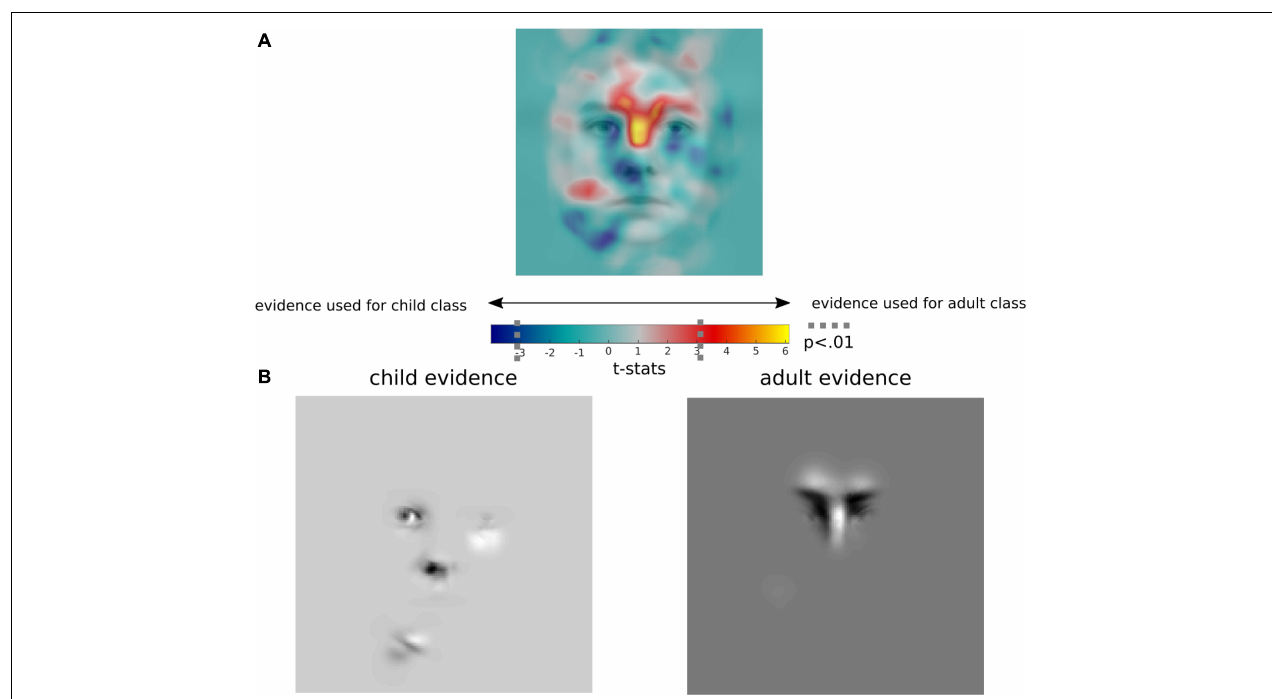
FIGURE 2 | Facial features for child and adult categorisation. Regression coefficients for 2D feature positions (for accurate classification of child and adult images) were spatially smoothed, and compared between child and adult faces with unpaired t -tests. On the first panel (A) , hot colours (positive t -statistics) indicate evidence for accurate adult classification, and cold colours (negative values) indicate evidence for accurate child classification. The two bottom panels (B) show pixels (i.e., regions of faces) significantly linked to accurate child and adult categorisation, respectively. (Image source: Langner et al., 2010).